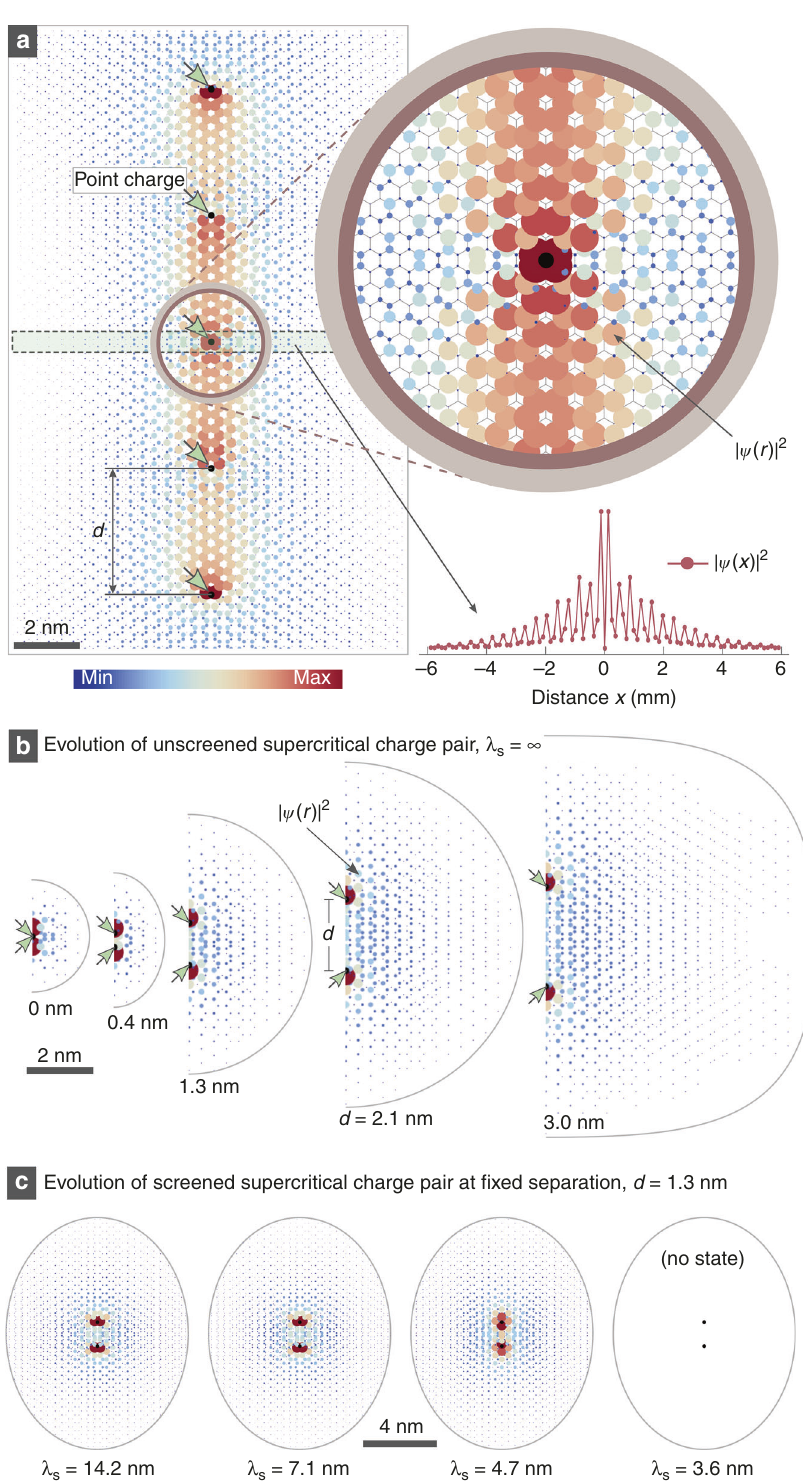
Fig. 4 Theoretical wave functions for frustrated supercritical states. a Density plot of the wavefunction associated with a supercritical resonant state in graphene near the Dirac point obtained from exact diagonalization of the Hamiltonian discussed in the text (same parameters as in Fig. 2). Black dots mark the positions of the Coulomb centers used in the calculation and the colored disks re fl ect the state ’ s local probability density, both through size and color. The charges are separated by d = 3.8nm as in the experimental 2 a array and the total system has 16,000 carbon atoms spanning 19×21 nm 2 (the image shown is cropped). The top inset shows a close-up near the central charge, where rapid decay is visible against the underlying honeycomb lattice. The bottom inset shows the wavefunction cross-section along a line perpendicular to the array (boxed region, cf. Supplementary Note 9). b Wavefunction of the most bound supercritical state for a pair of unscreened charges at the following charge separations: d = 0nm, d = 0.4nm, d = 1.3nm, d = 2.1nm, and d = 3.0nm ( Z = 0.8 Z C ). Each wavefunction is shown in the region where its value is at least 1% of its maximum. The characteristic wavefunction extension is ~ d . c The same as ( b ) but with a fi xed charge separation ( d = 1.3nm) and a varying screening length λ λ ≤ 3.6nm (cf. Supplementary Fig. S as indicated. Supercritical states disappear for S